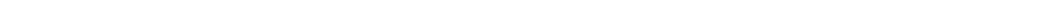
the best clinical treatment of myocardial infarction 52,53 . In these studies, superior hCPCs were created during ex vivo expansion under hypoxic conditions to improve their quality and quantity. These cells reveal better qualities in terms of high proliferation ability, low chromosomal